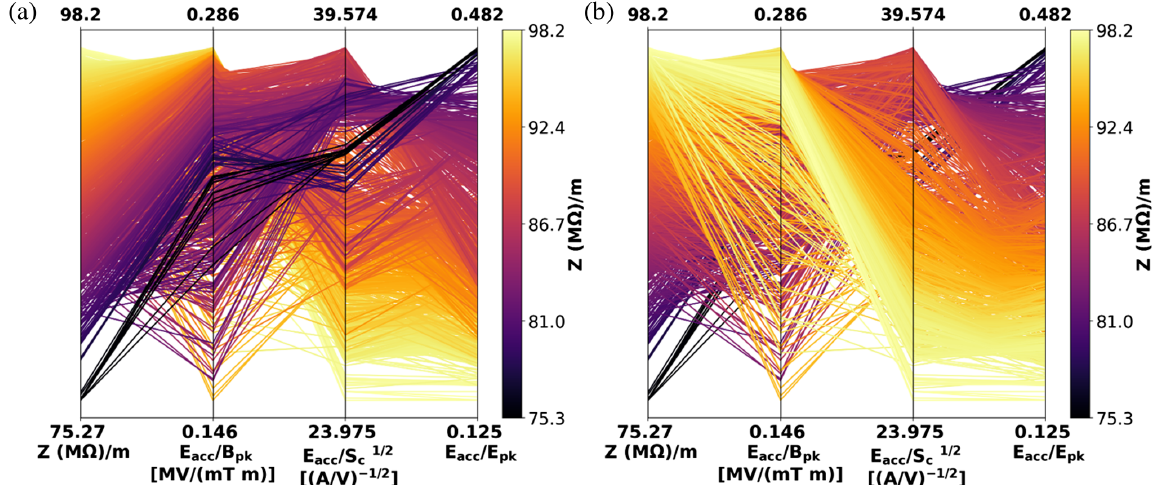
FIG. 17. PCPs showing the Pareto optimal space for a C-band SW single cell. The same plot is displayed twice with different plot order, where (b) is the reverse of (a). All objectives require